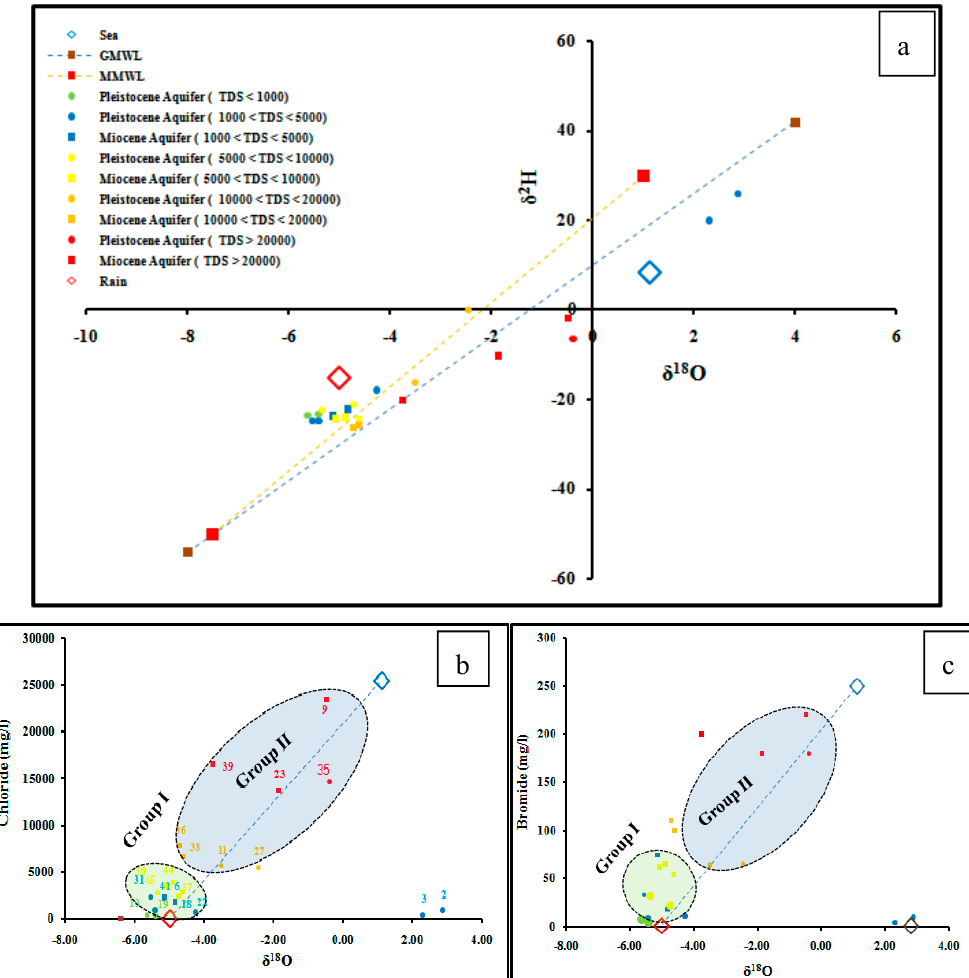
Figure 7. ( a ) The relationship between δ 18 O and δ 2 H; ( b ) The relationship between δ 18 O and Cl; ( c ) The relationship between δ 18 O and Br.